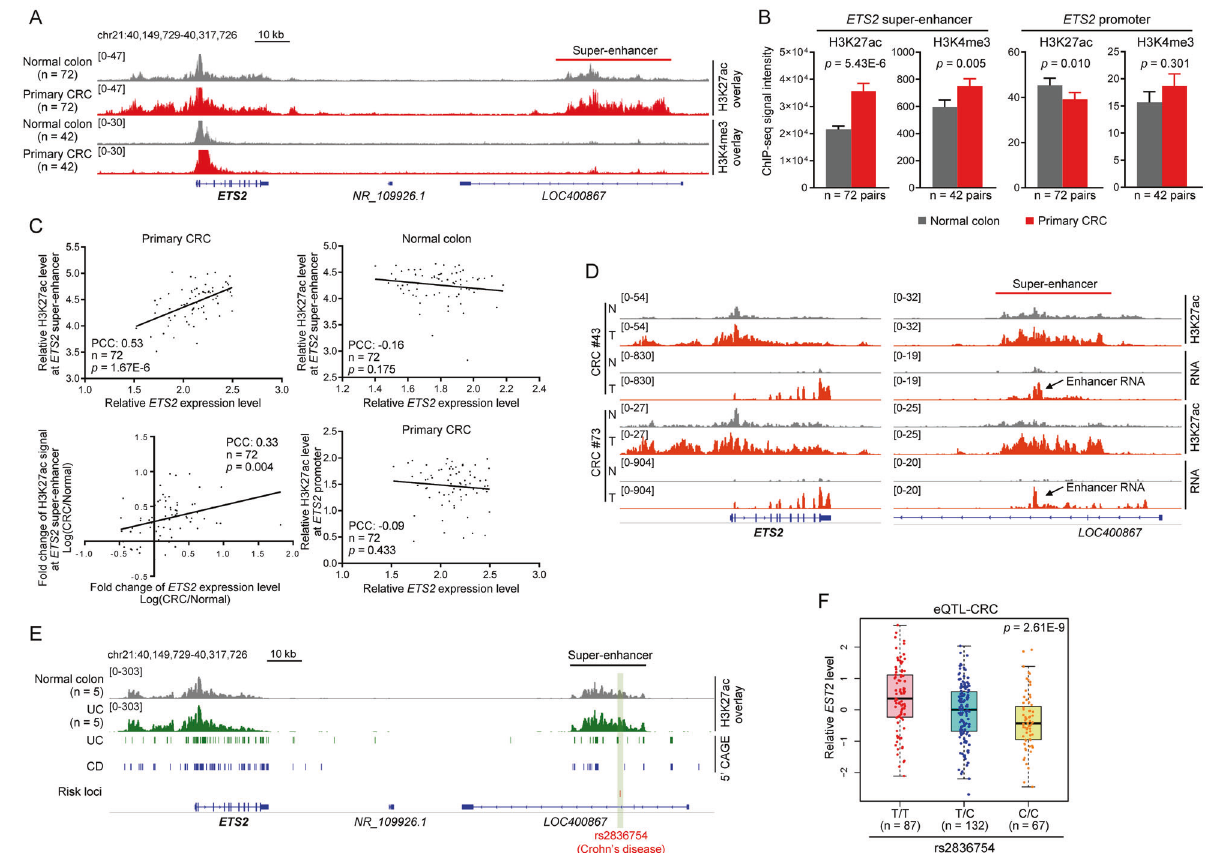
Fig. 3 The ETS2 -SE is highly disease-speci fi c in both CRC and IBD and its activity is strongly correlated with the expression level of ETS2 in CRC. A Overlayed IGV tracks showing the H3K27ac ( n = 72) and H3K4me3 ( n = 42) ChIP-seq pro fi les in paired normal colon (gray) and primary CRC samples (red) across the ETS2 promoter and its distal SE. B Quanti fi cation of the ChIP-seq signal (RPGC in a bin size of 10 bp) from samples described in ( A ) at ETS2 promoter or its distal SE. C Scatter plots showing the correlation between ETS2 expression level and H3K27ac level at ETS2 -SE or ETS2 promoter in primary CRC or normal colon tissues. PCC Pearson Correlation Coef fi cient. D IGV tracks showing the H3K27ac ChIP-seq and RNA-seq pro fi les in normal colon tissue (N) or primary tumor (T) from two CRC patients at indicated regions. Loci of active enhancer transcription in CRC were indicated by black arrows. E Upper panel: IGV tracks showing the overlayed H3K27ac ChIP-seq pro fi les in normal colon tissue ( n = 5, gray) or UC colon tissue ( n = 5, dark green) at indicated regions. Bottom panel: 5 ’ CAGE peaks labeling active transcription events from two representative UC and CD samples. The position of a known IBD-risk SNP was indicated by green rectangle in shadow. F Results of eQTL analysis in primary CRCs showing differential ETS2 expression level in samples with different risk SNP